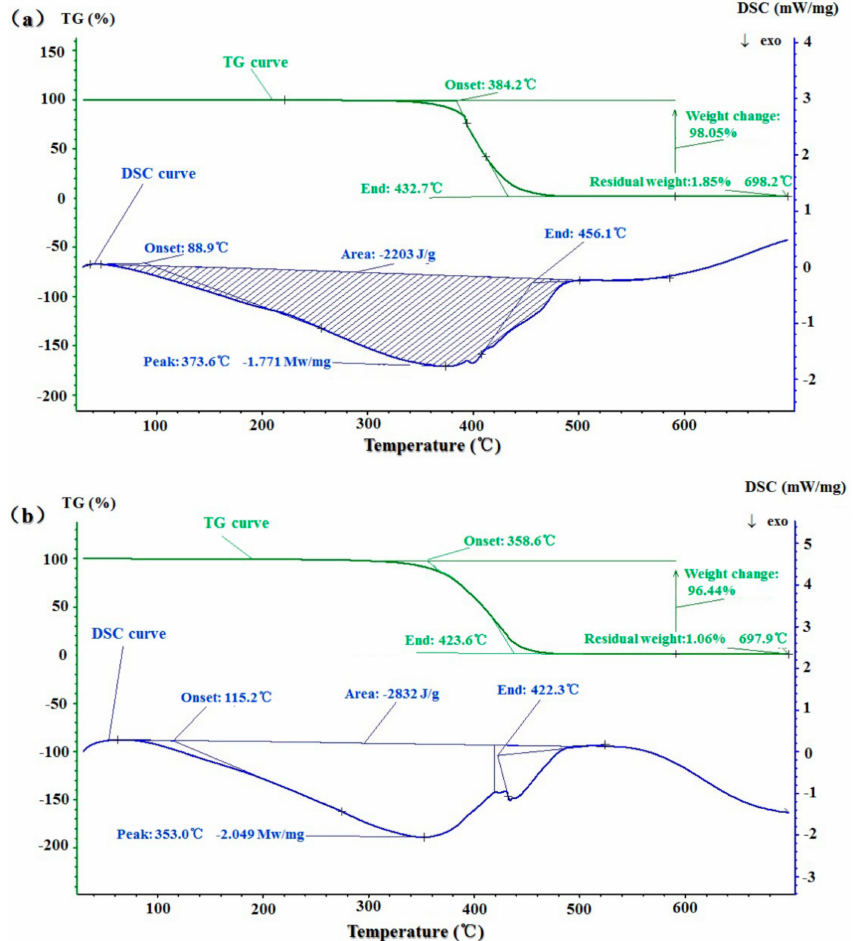
Figure 8. Thermogravimetric and di ff erential scanning calorimetry (DSC) curves of B. dasystachya seed oil obtained by di ff erent methods: ( a ) The SC-CO 2 extraction method; ( b ) The PEE